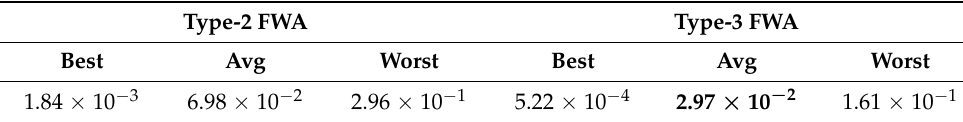
Table 8. First data period (future prediction, China).